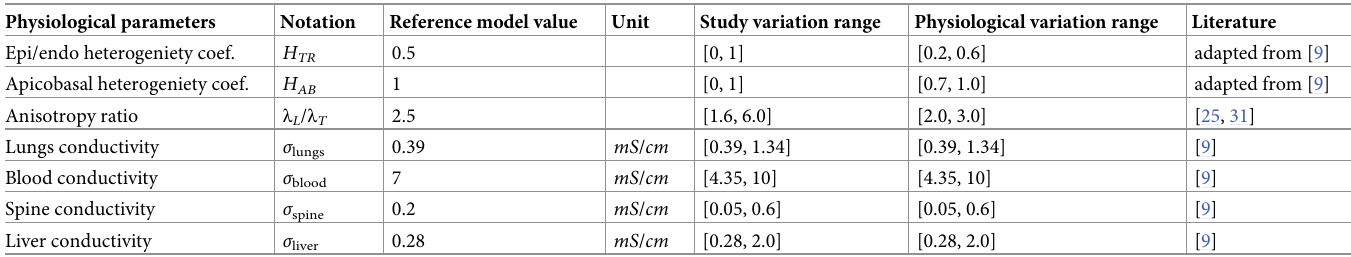
Table 3. Model parameters that varied in the